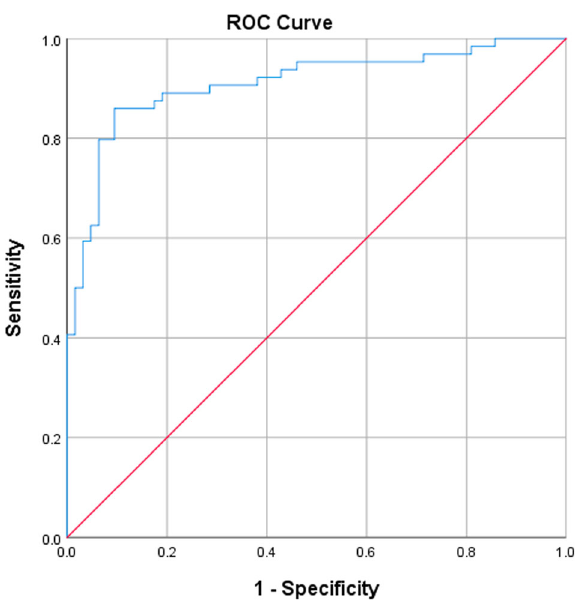
Fig. 2 Receiver operator curve. Acute exacerbation of COPD (All ages): AUC = 0.89 (95% CI: 0.84 – 0.94).